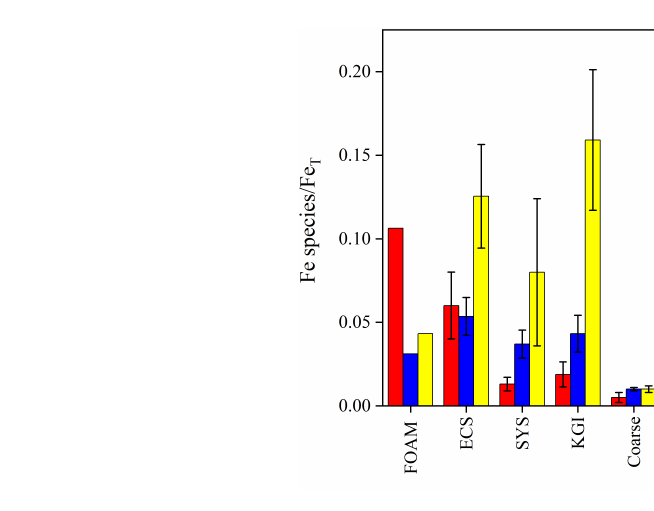
FIGURE 5 Fe carb /Fe T , Fe ox1 /Fe T and Fe ox2 /Fe T ratios in “ Coarse ” , “ Medium ” , “ Fine ” and “ Ultra- fi ne ” categories of sediments from Prydz Bay and the adjacent Southern Ocean, as well as in sediments from FOAM (friends of anoxic mud) (Can fi eld, 1989), the ECS (East China Sea) (Zhu et al., 2012), SYS (South Yellow Sea) (Ma et al., 2018) and KGI (King George Island) (Henkel et al., 2018). Data are averages of surface sediments (0 – 2 cm) by recalculation of Can fi eld (1989) and Henkel et al.